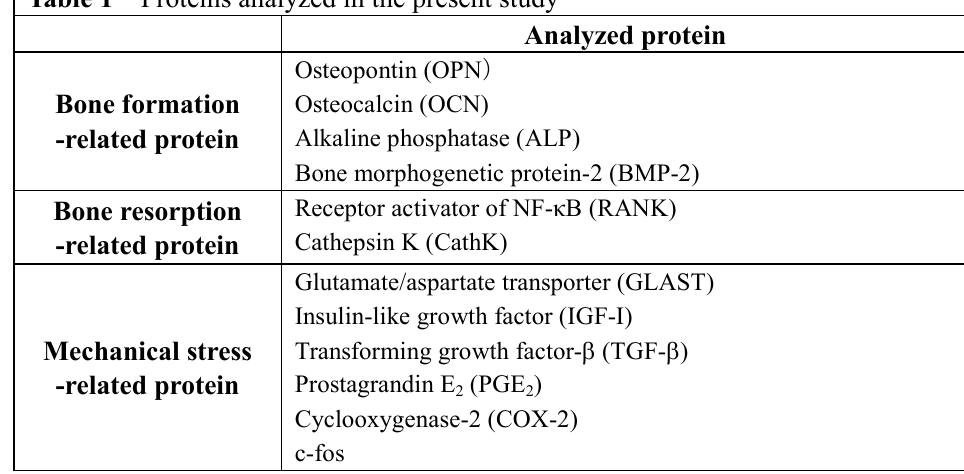
Proteins analyzed in the present study